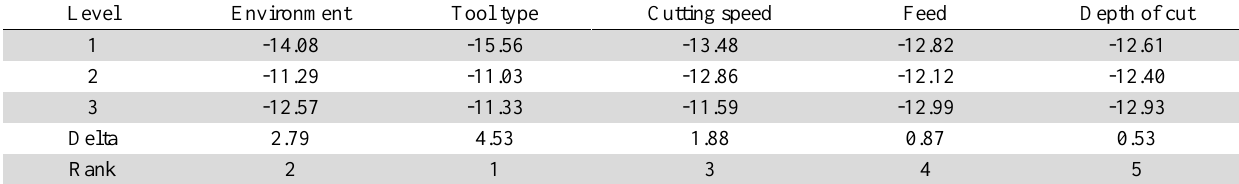
Response Table for Signal to Noise Ratios for Surface Roughness (Smaller is better) Level